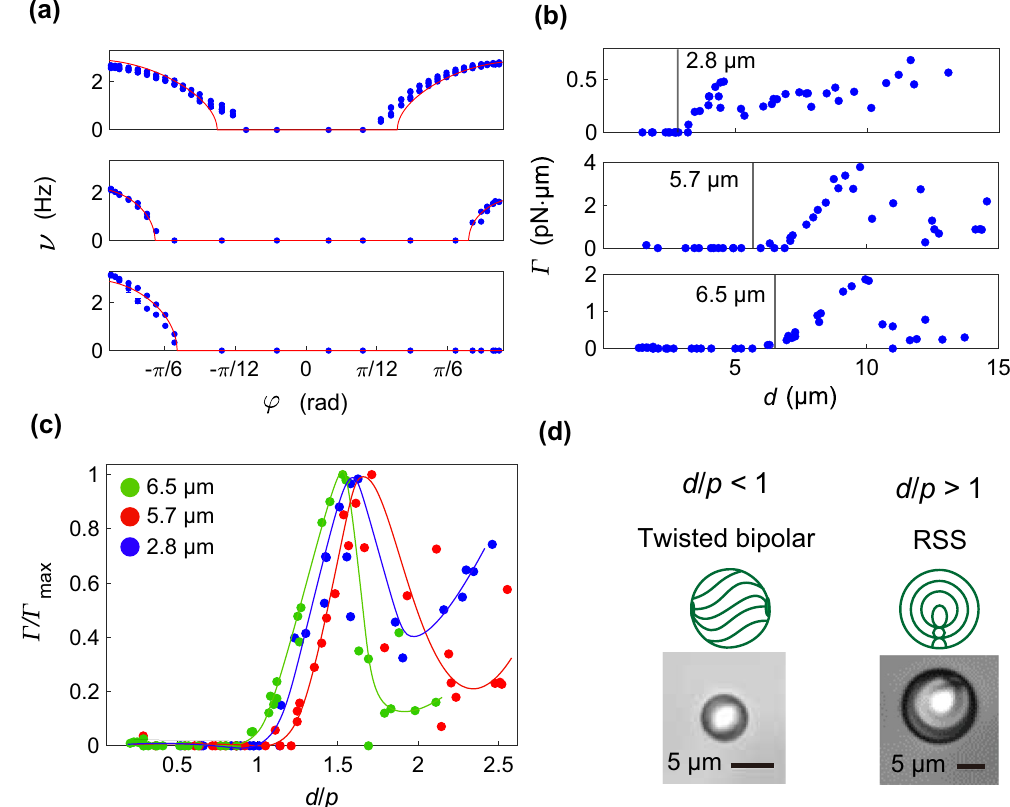
Figure 2. Optically induced continuous rotation of ChLC (E7+R-811) droplet. ( a ) Variation in rotation frequency ν with ellipticity angle of polarized light φ with 10 mW laser power for NLC droplets and 25 mW for ChLC droplets. The R-811 concentrations are 0 wt% (top), 0.3 wt% (middle), and 1.0 wt% (bottom). The red lines are theoretical curves fitted using Eq. (5). ( b ) Variation in applied torque Γ with diameter d for three ChLC droplets with different amount of R-811 (upper: 4.6 wt%, middle: 0.7 wt%, and lower: 0.1 wt%). The vertical line indicates pitch p of ChLC. 17.5 mW laser power was used. ( c ) Variation in scaled optical torque Γ / Γ max with scaled diameter d/p . The solid lines are eye guides. ( d ) Bright field microscopic images and schematically shown molecular alignment of ChLC droplets with twisted bipolar structure and RSS. For d/p < 1, the inner structure is twisted bipolar; for d/p > 1, the inner structure is